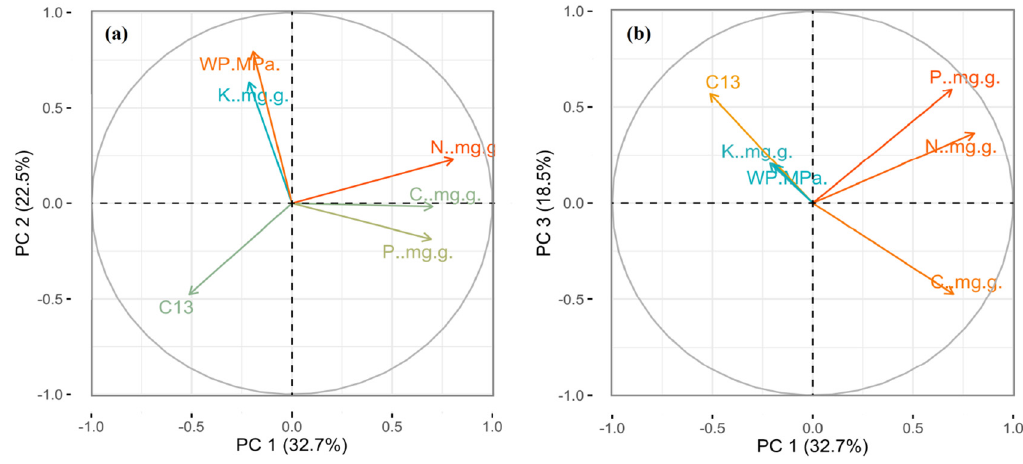
Figure 4. The expression of six leaf traits on the three principal components analysis (PCA) axes at the species level ( N = 37 ). ( a , b ) Loading values of six leaf traits for PC axis 1, 2 and PC axis 1, 3, respectively. Different colors show the contribution of each variable.